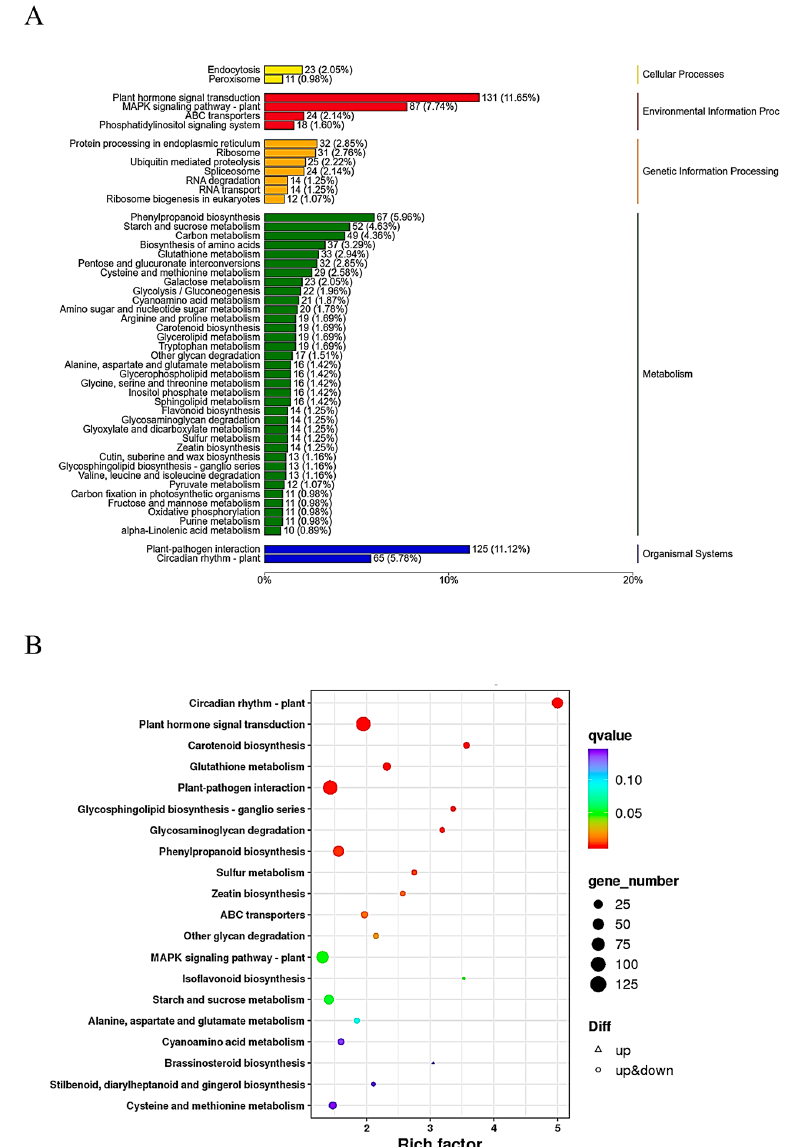
Figure 3. KEGG pathway enrichment analysis of DEGs in GB767 vs. PB767. ( A ) KEGG classification of DEGs. ( B ) The bubble diagram of the top 20 enriched KEGG pathways. The larger the bubble size, the more the number of DEGs. The smaller the q value, the greater the signi fi cance.